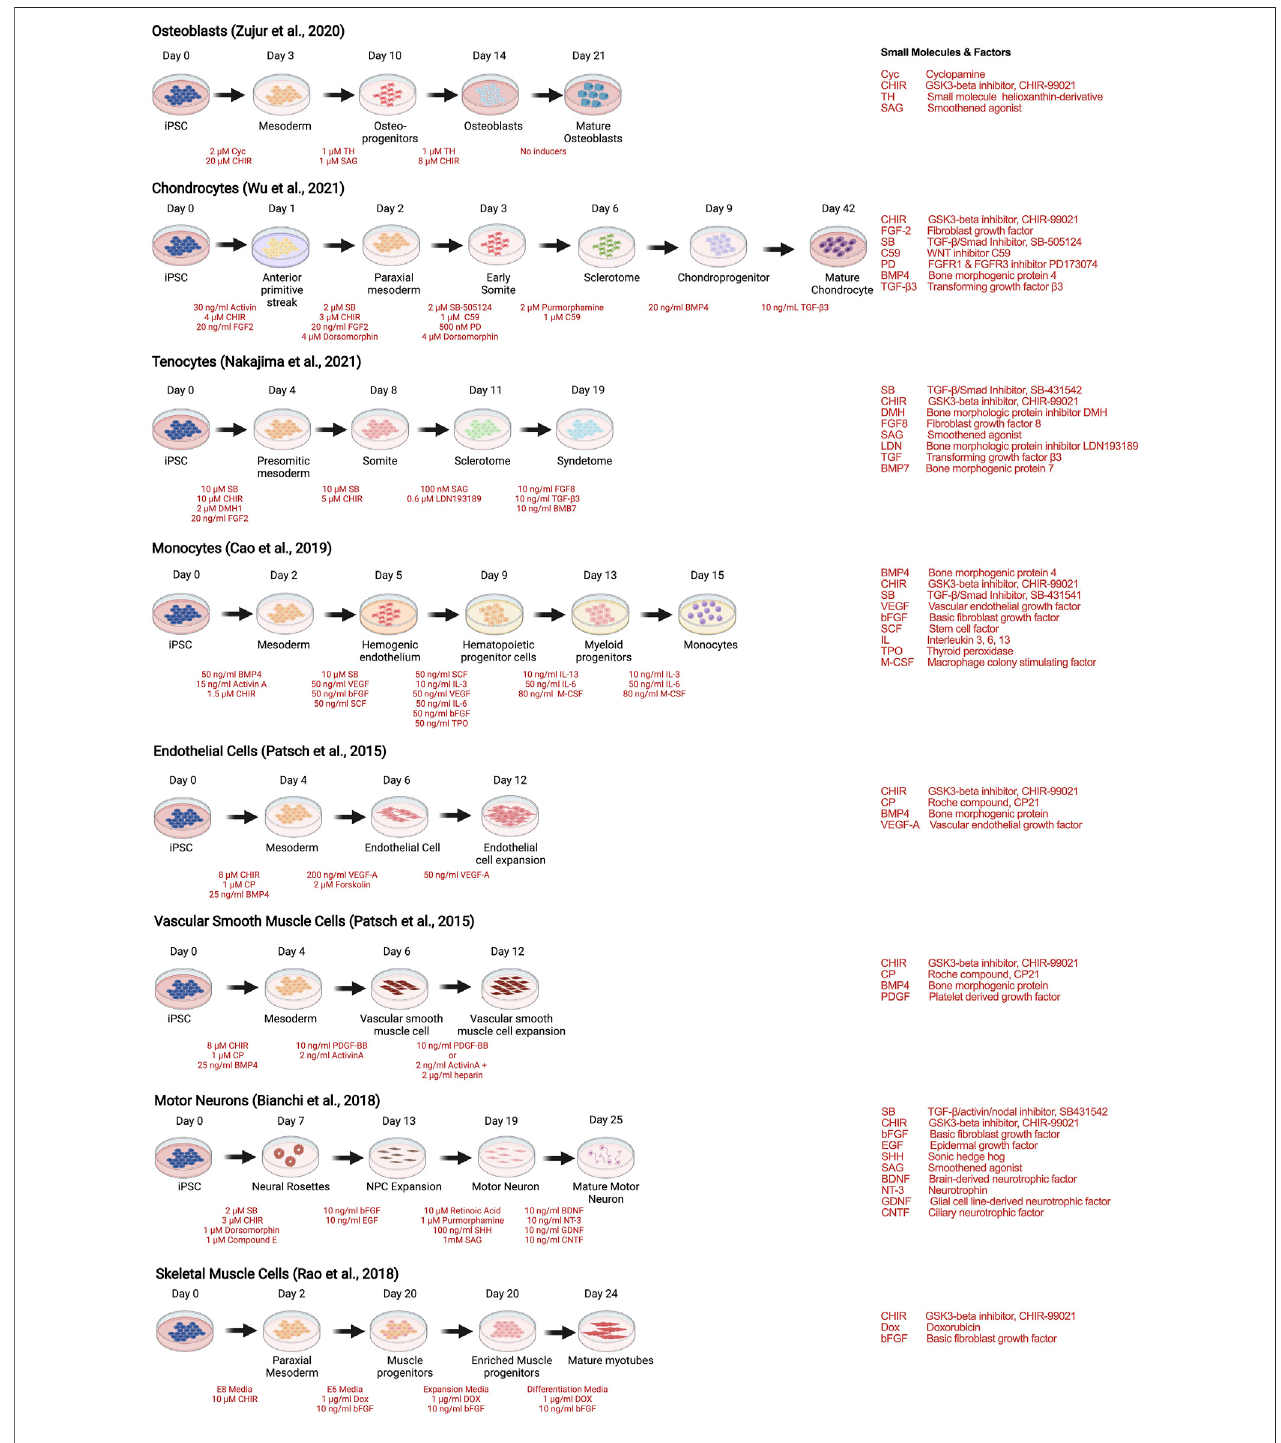
FIGURE 4 | Strategies to derive musculoskeletal cells from human iPSCs through stepwise differentiation.